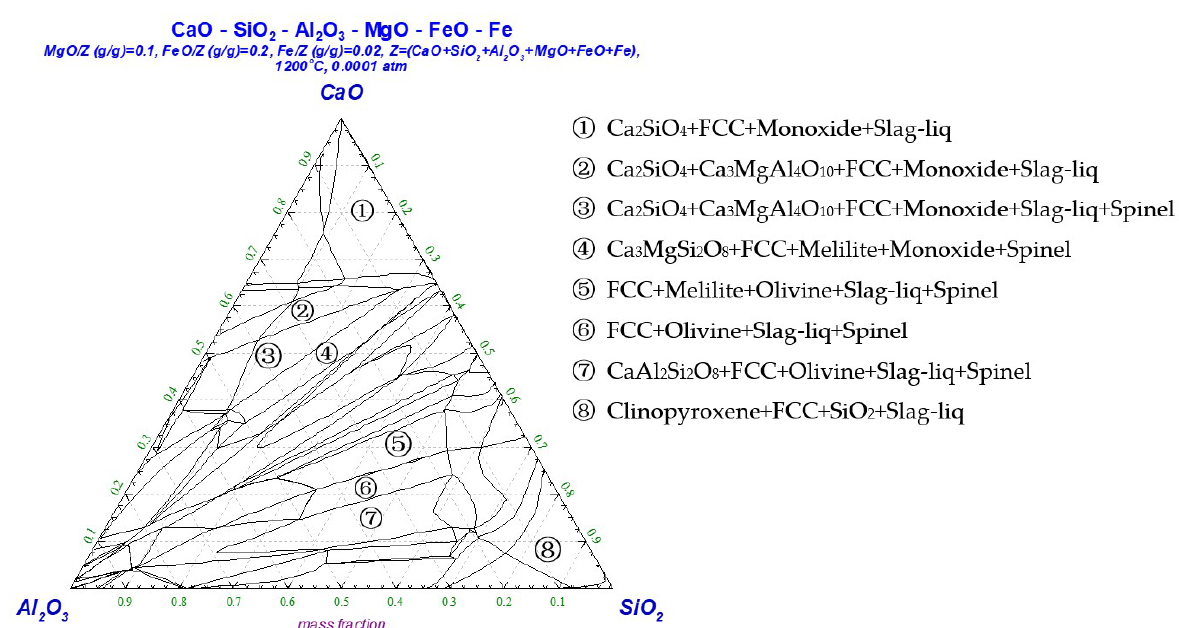
Figure 17. CaO-SiO 2 -Al 2 O 3 ternary phase diagram.